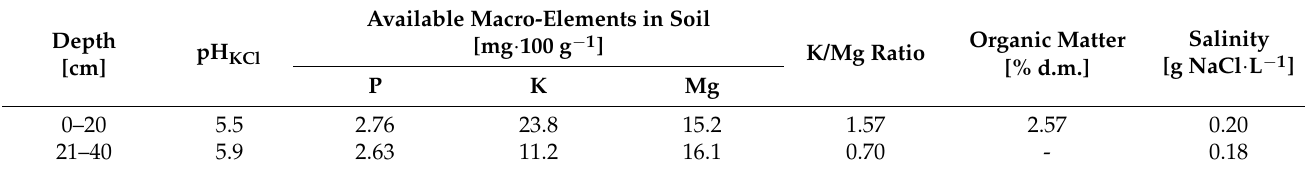
Table 2. Soil parameters of the experimental site measured in autumn 2016 prior to tree